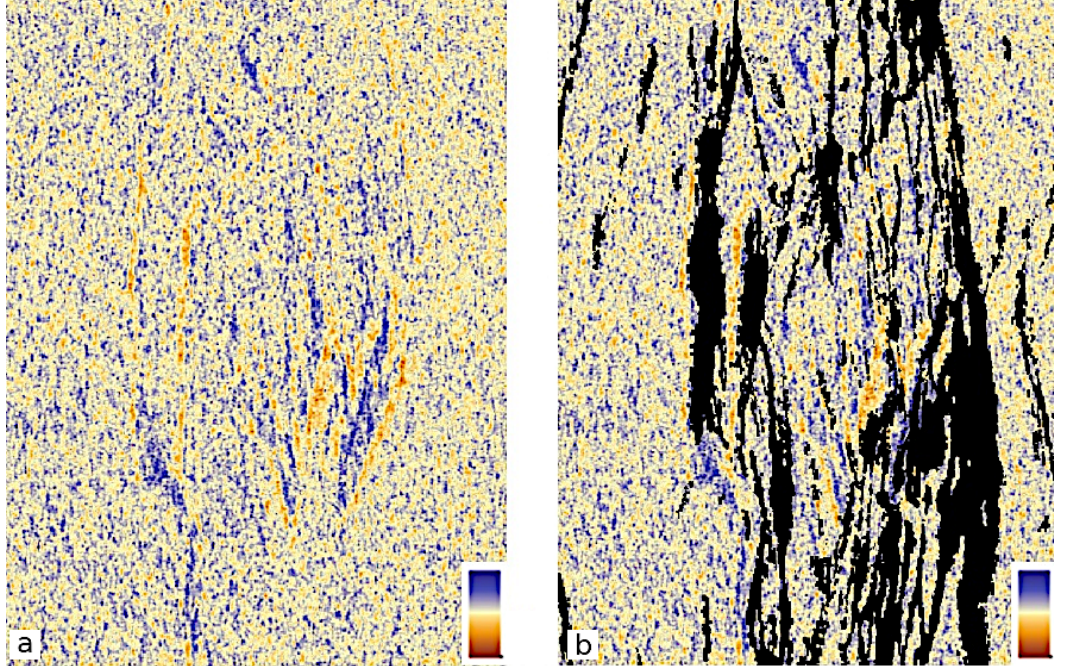
Figure 5. Panels ( a , b ) are slant-range Log-Ratio (LR) index images covering the same area. Pixels shown in the blue area represent a location with reduced intensity, while pixels in orange indicate a location with increased intensity values. The invisible-masking method is performed in ( b ), in which black pixels represent areas characterized by topographic distortion. From the comparison of ( a , b ), it can be seen that intensity change features can be obtained in the image without invisible